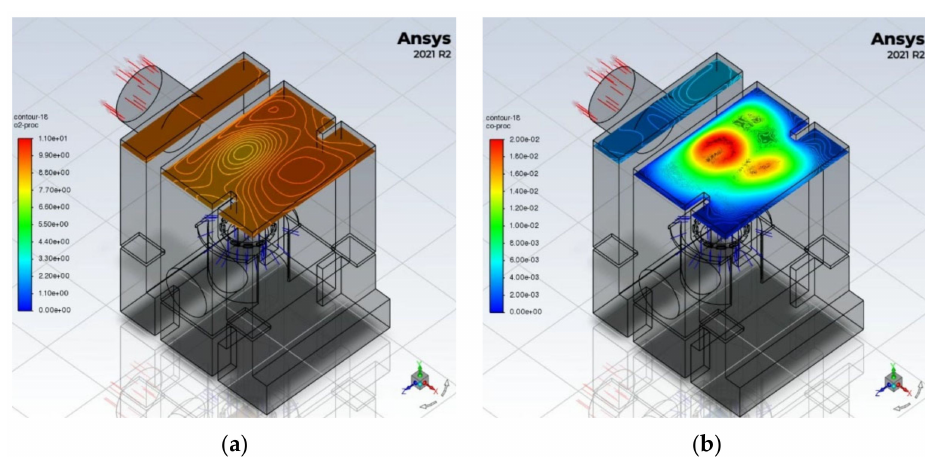
Figure 4. Temperature distribution [K].